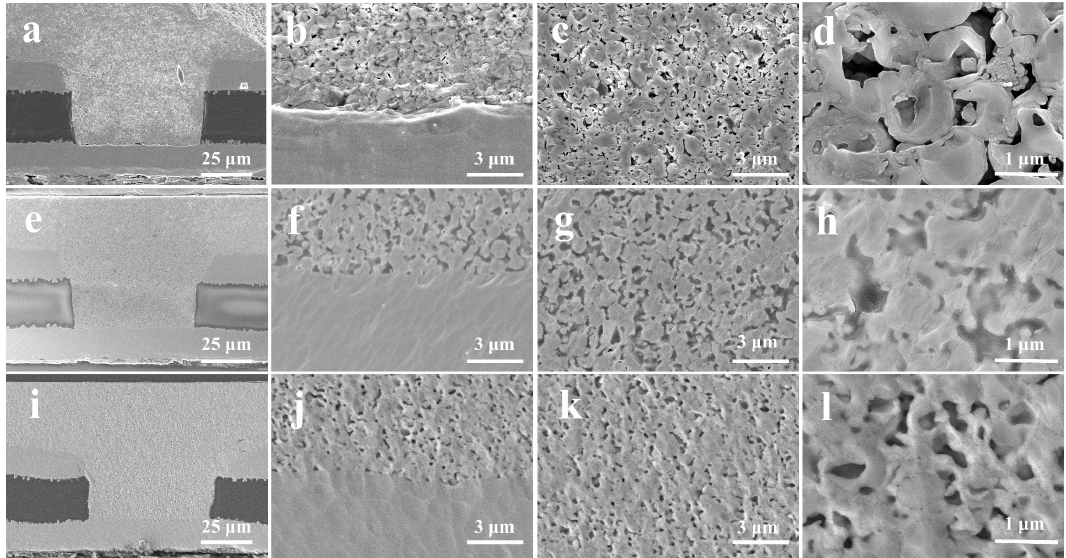
Figure 7. SEM images of the microvias filled with Cu@Ag NMPs at the sintering temperatures of 220 °C and sintering time of ( a – d ) 10 min, ( e – h ) 30 min, and ( i – l ) 50 min.